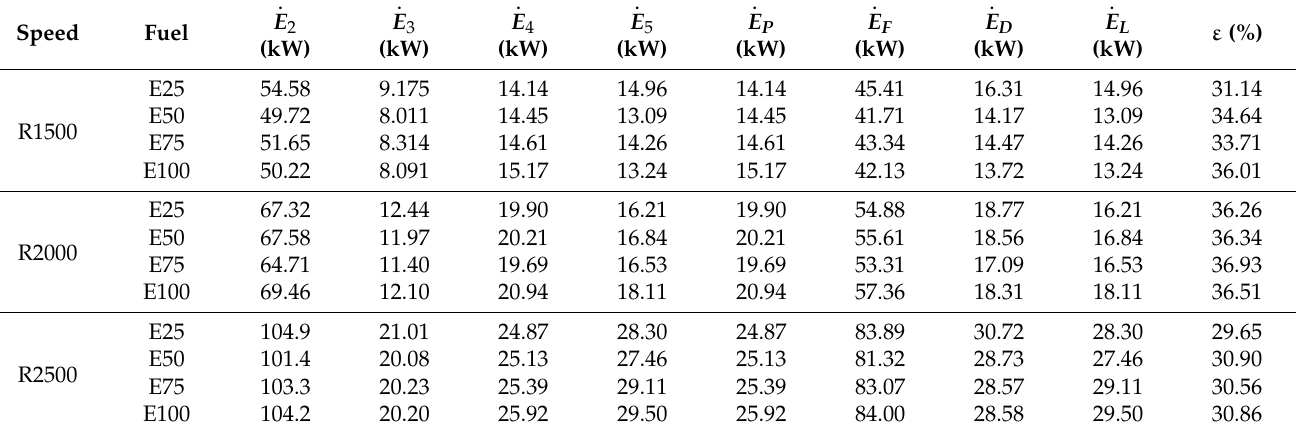
Table 6. Exergy analysis results.